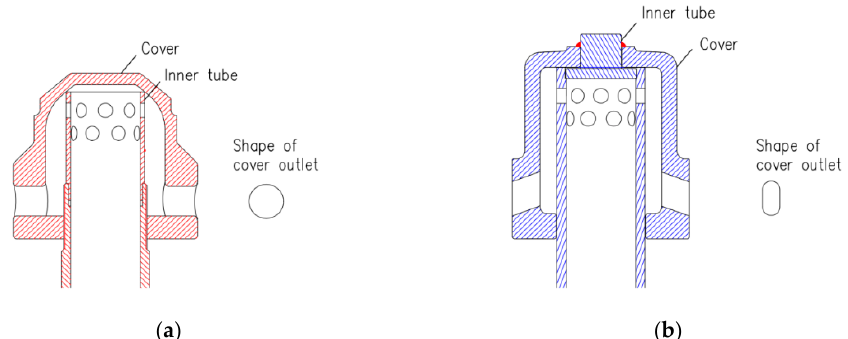
Figure 2. Schematic diagram of bell-type air nozzle: ( a ) traditional design (nozzle A); ( b ) new design (nozzle B).